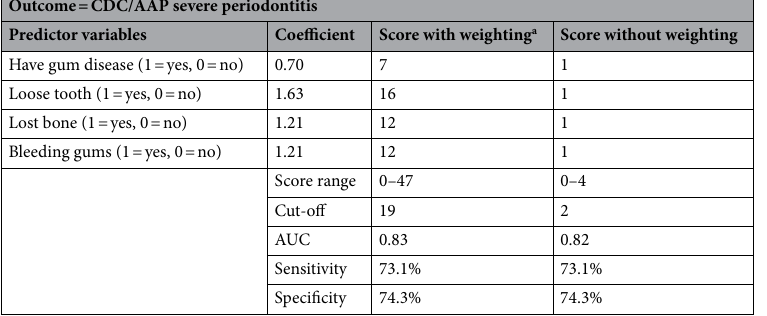
Table 5. Multivariable regression coefficients and screening score for periodontitis. AAP, American Academy of Periodontology; AUC, area under the receiver operating characteristic curve; CDC, Centers for Disease Control and Prevention. a The weighted score was calculated using the coefficients obtained from the parsimonious model for the self-reported oral health